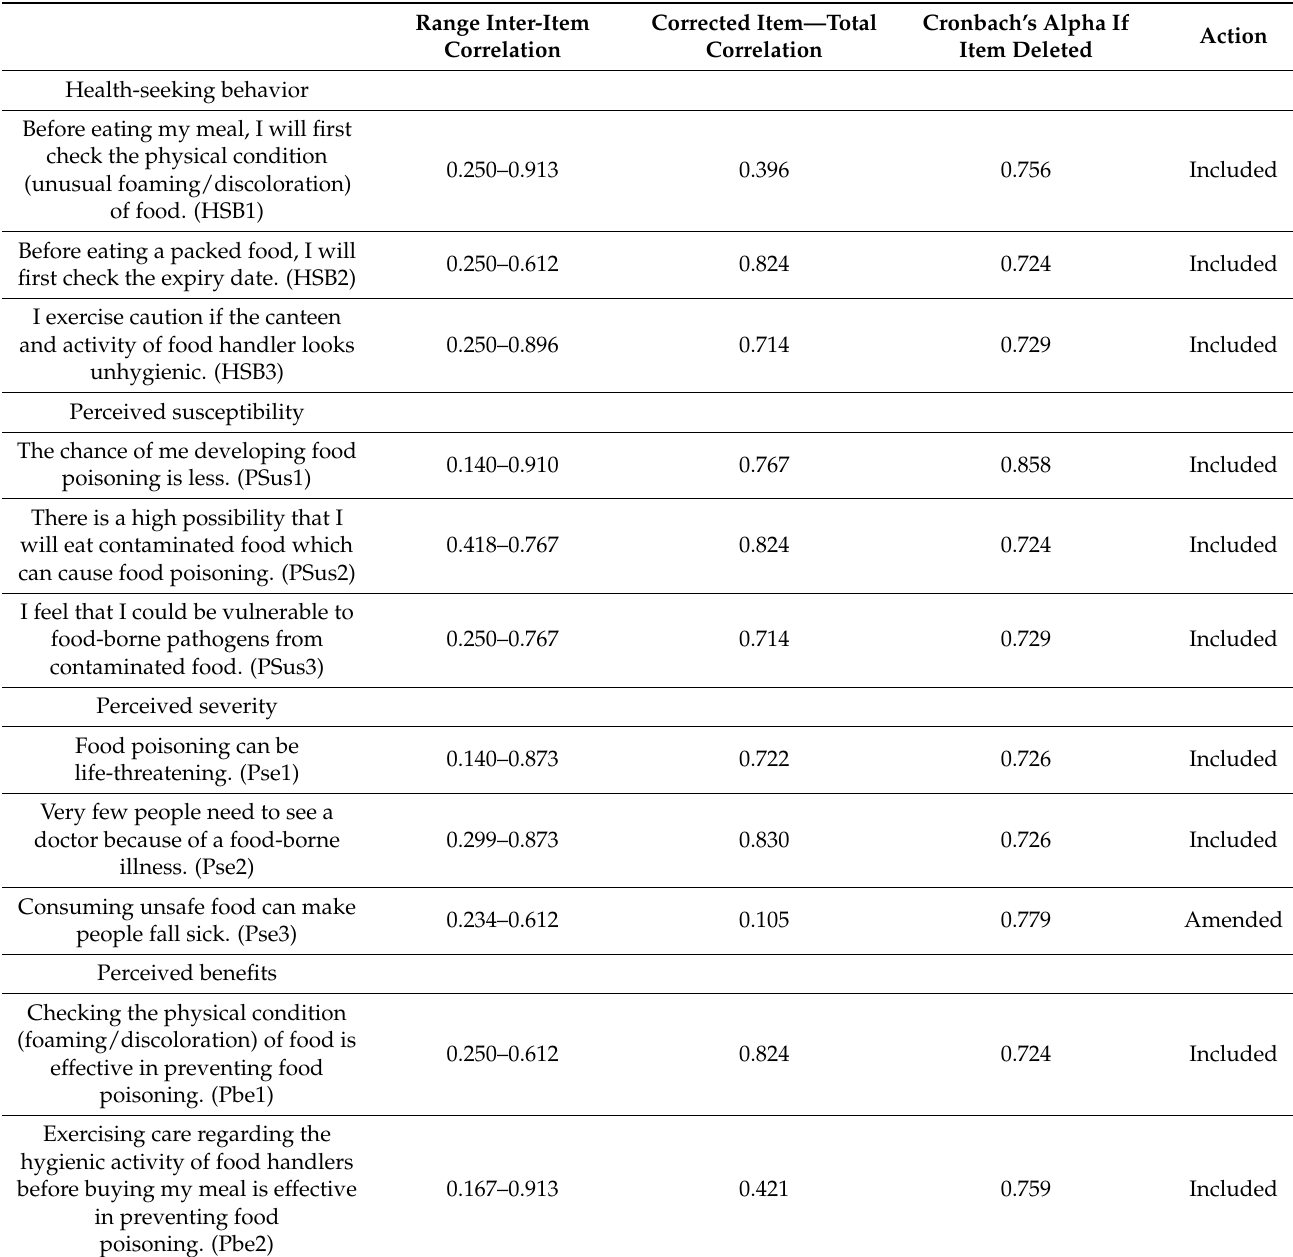
Table 5. Item analysis of perception toward prevention of food